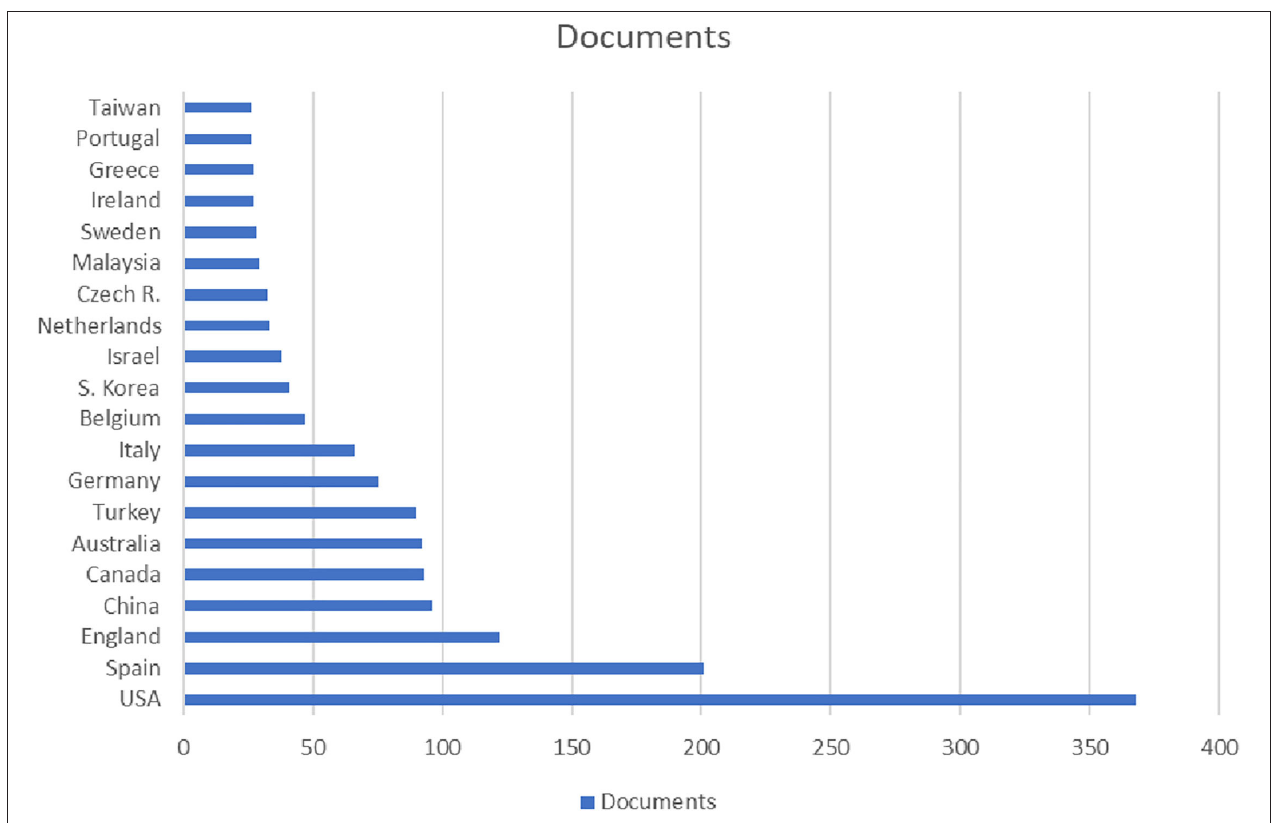
FIGURE 1 | Distribution of the number of publications by country (we considered the first 20 countries in the drawing of the visual network